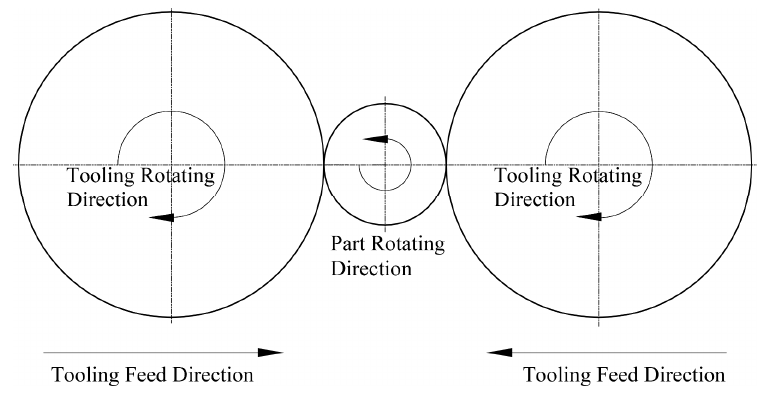
Figure 2. Schematic view of the experimental apparatus.